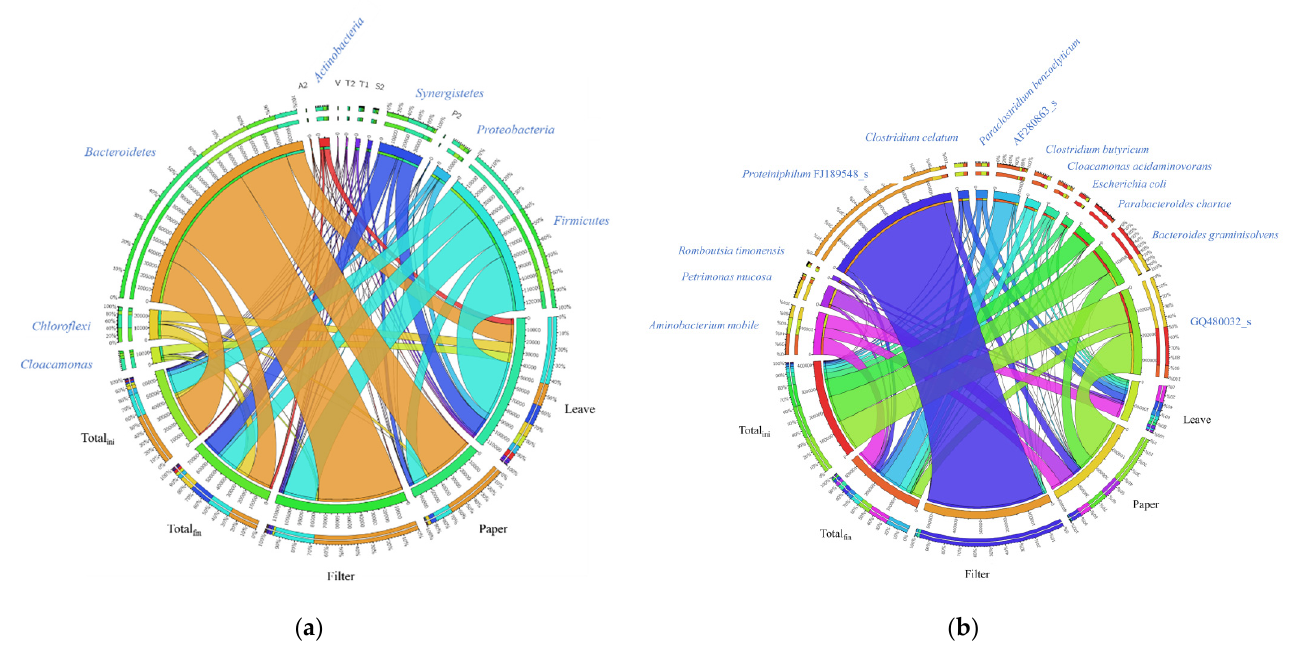
Figure 4. Circos representation of bacterial communities from the anaerobic digestion of intact cigarettes or individual components as: ( a ) phylum level; ( b ) species level. Table 2. Bacterial microbes (species level) in an AD reactor fed cigarette butts or individual components. Numbers represent the distribution as percentage at the species level, and the column colors indicate high distribution in the three components: pink (filter), paper (yellow), and leaf